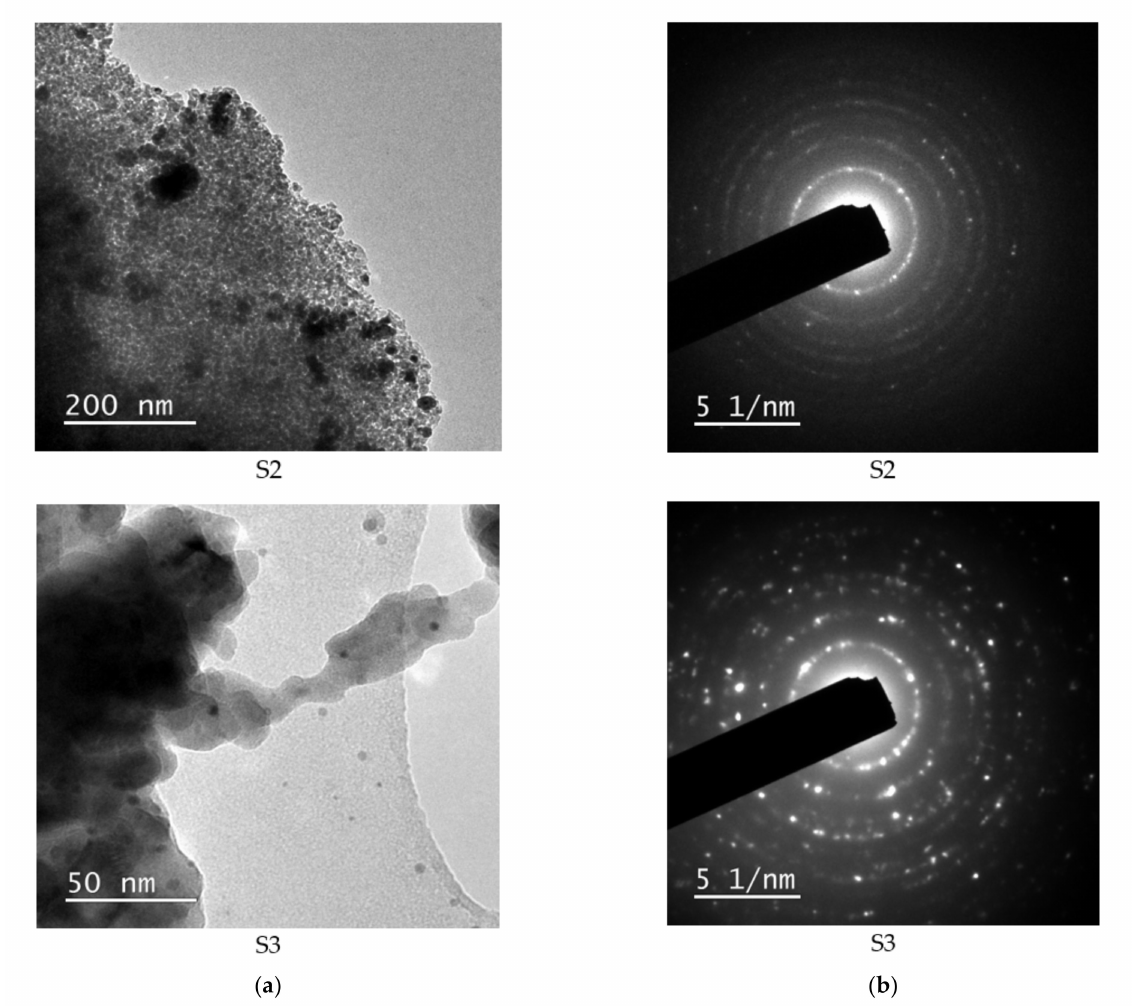
Figure 3. ( a ) TEM micrographs and ( b ) SAED images of samples with S2 and S3. The FTIR spectra of the samples are shown in Figure 4. The broad bands situated between 3500 and 3000 cm − 1 are due to the stretching vibrations of the hydroxyl groups, while the peak around 1620 cm − 1 is ascribed to hydroxyl groups bending. The band at 1384 cm − 1 is assigned to the organic residual compounds embedded in the titania, from the ethanol used in the synthesis and from the isopropanol formed during the hydrolysis step. The large band between 800 and 400 cm − 1 contains many small peaks, and can be attributed to the stretching vibrations corresponding to the Ti–O or O–Ti–O bondings [34]. In the spectra of S2 and S3 samples, important changes appear. The bands observed between 3500 and 3000 cm − 1 and 1620 cm − 1 have higher intensities, indicating the enrichment of the structure in surface hydroxyl groups, as does the band at 1384 cm − 1 , highlighting an increase in the number of sites where organic matter from the two alcohols, as well as from hydrazine, remains bonded. The region between 800 and 400 cm − 1 was significantly changed due to the Ag nanoparticles present. According to Ahmed et al. [35], the bands at 645 and 725 cm − 1 are due to Ag nanoparticles. The surface areas of the samples were, respectively, 20.35 m 2 g − 1 for S1, 25.37 m 2 g − 1 for S2 and 21.69 m 2 g − 1 for